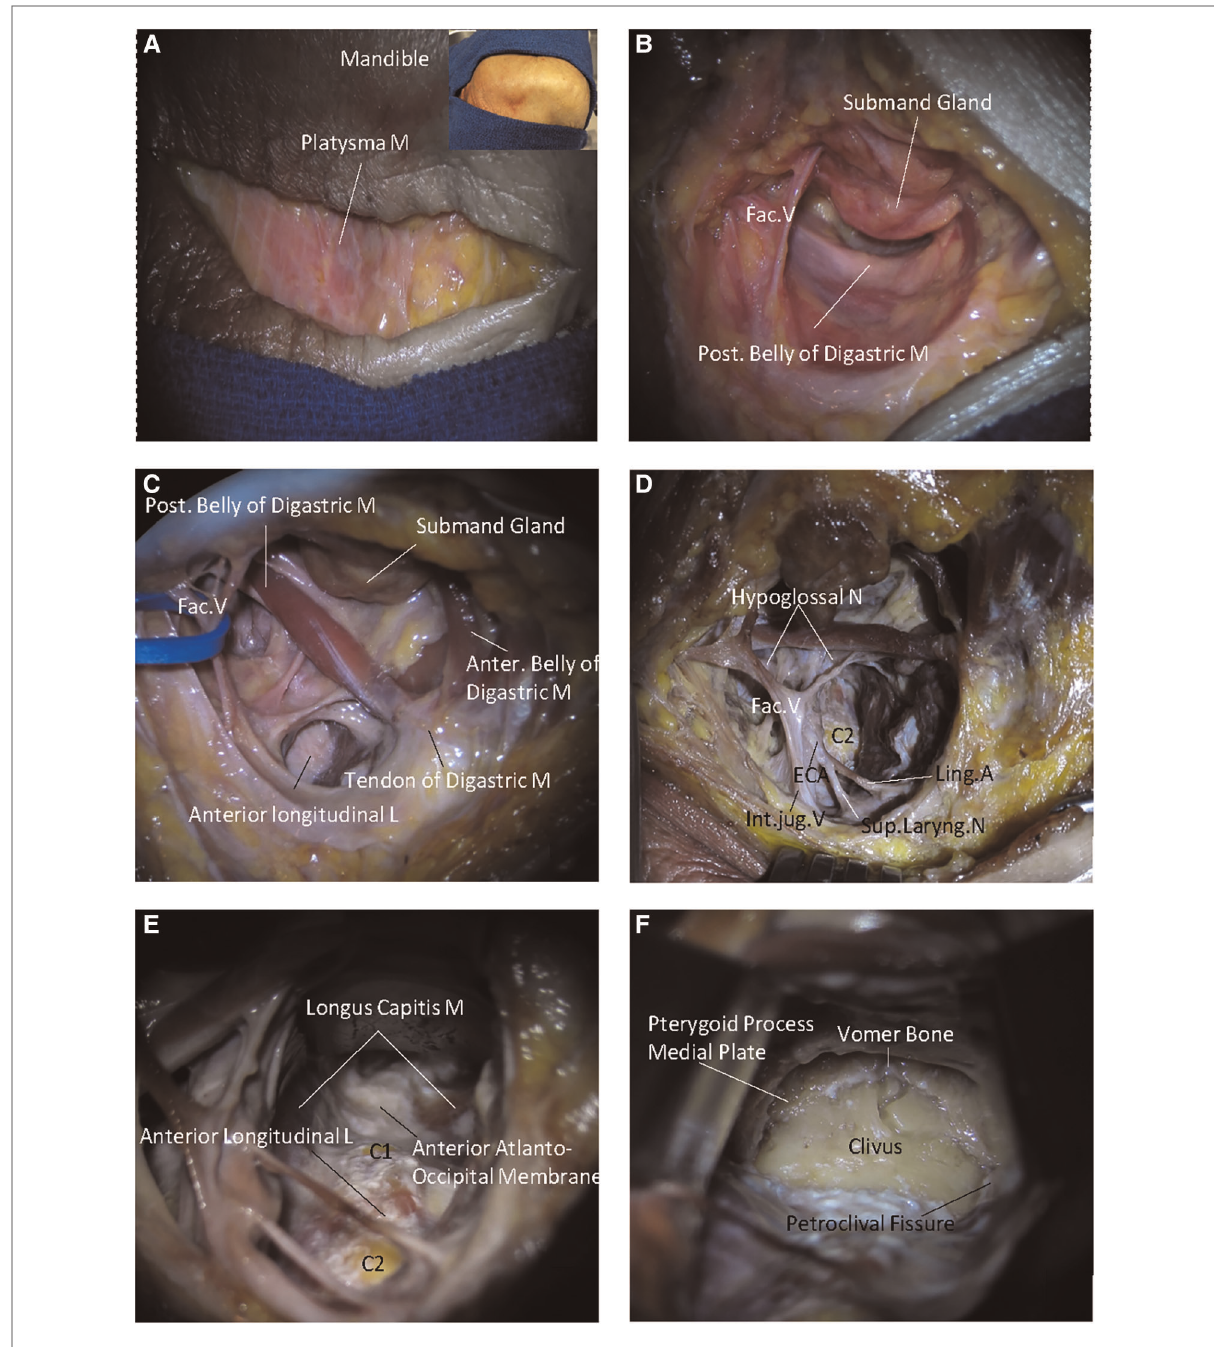
FIGURE 1 The surgical procedure of endoscope-assisted high anterior cervical approach. ( A ) A straight skin incision is made about 2 cm below and parallel to the inferior border of the mandible. ( B ) The platysma muscle is elevated. The submandibular gland and posterior belly of the digastric muscle are exposed. ( C ) The submandibular gland and posterior belly of the digastric muscle are released and retracted and the entrance of the retropharyngeal space is exposed. ( D ) The hypoglossal nerve passes and the lingual artery is divided; and the retropharyngeal space is opened. ( E ) The pharyngeal muscles are retracted medially and further separated deeply. The anterior surface of the cervical vertebrae and anterior atlantooccipital membrane are exposed. ( F ) The lower clivus is exposed, including the vomer, pterygoid precess medial plate, petroclival, and the anterior rim of the foramen magnum. The arrows indicate the direction in the space, S represents the superior part of the cadaveric heads, M represents the medial part of the cadaveric